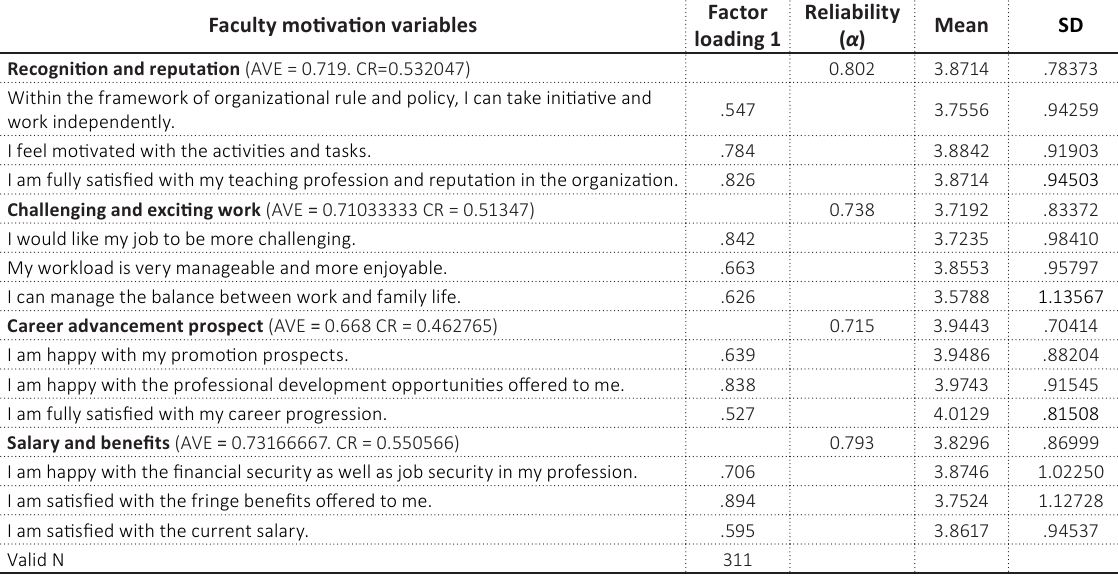
Table 4. Factors of faculty motivation: Descriptive statistics